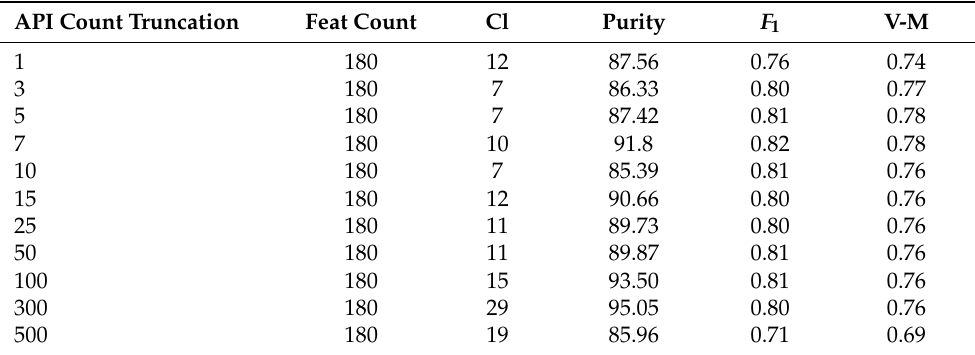
Table 4. Data Set 1C API count